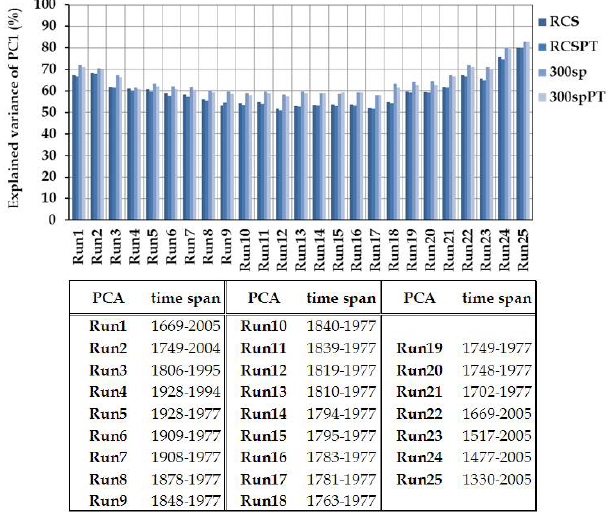
Fig. 3. Variance explained by the PC1 for each PCA run (1 to 25) and for each standardization method (RCS, RCSPT, 300sp, 300spPT). Time span for each PCA is shown in the